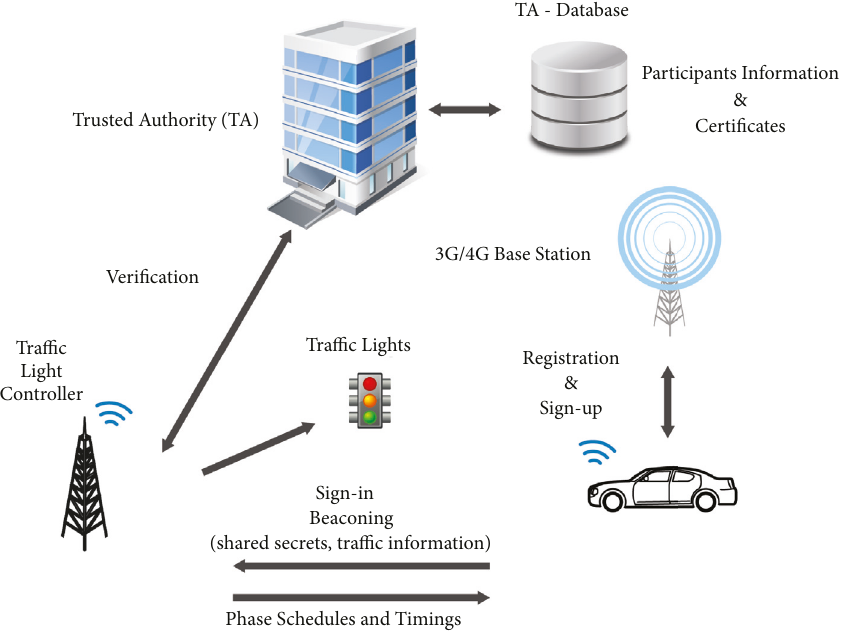
Figure 1: The system architecture with communication